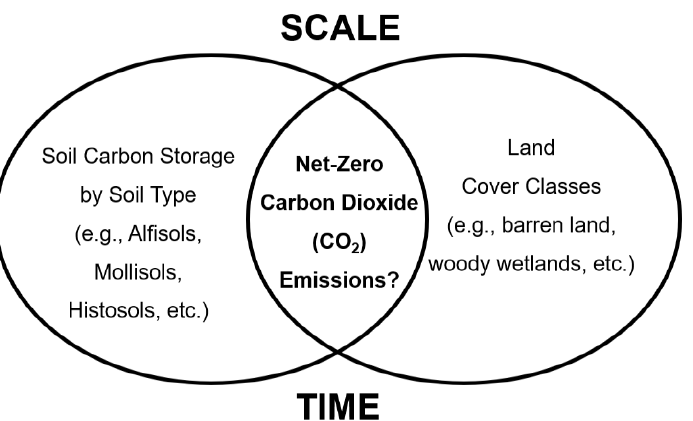
Figure 1. Net-zero carbon dioxide (CO 2 ) emissions from soils can be defined as a balance between the carbon footprint (CF), which is the intersection between land cover classes and soil C storage by soil type with anthropogenic/natural disturbance, and any C removal by soil. If the CF does not change over time, there is net-zero CO 2 emissions from soils (modified from Mikhailova et al., 2022 [4]).